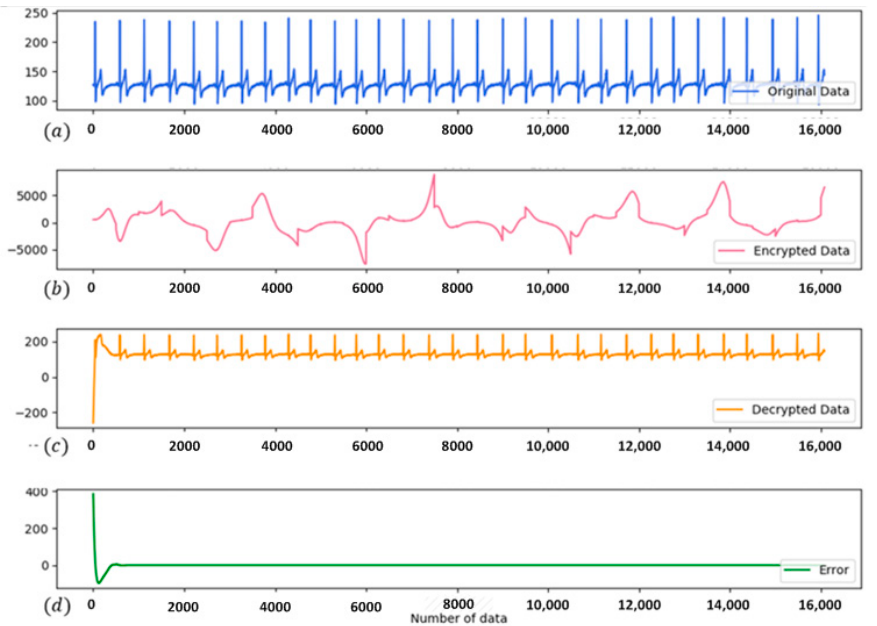
Figure 16. Simulation results of ECG. ( a ) The original data; ( b ) Encrypted data; ( c ) Decrypted data; ( d ) The error between the original data and decryted data.